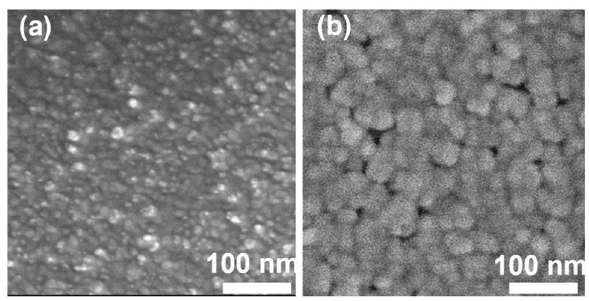
Figure 2. Top-view SEM image of Rh–Ir thin film: ( a ) before EJH; ( b ) after EJH.